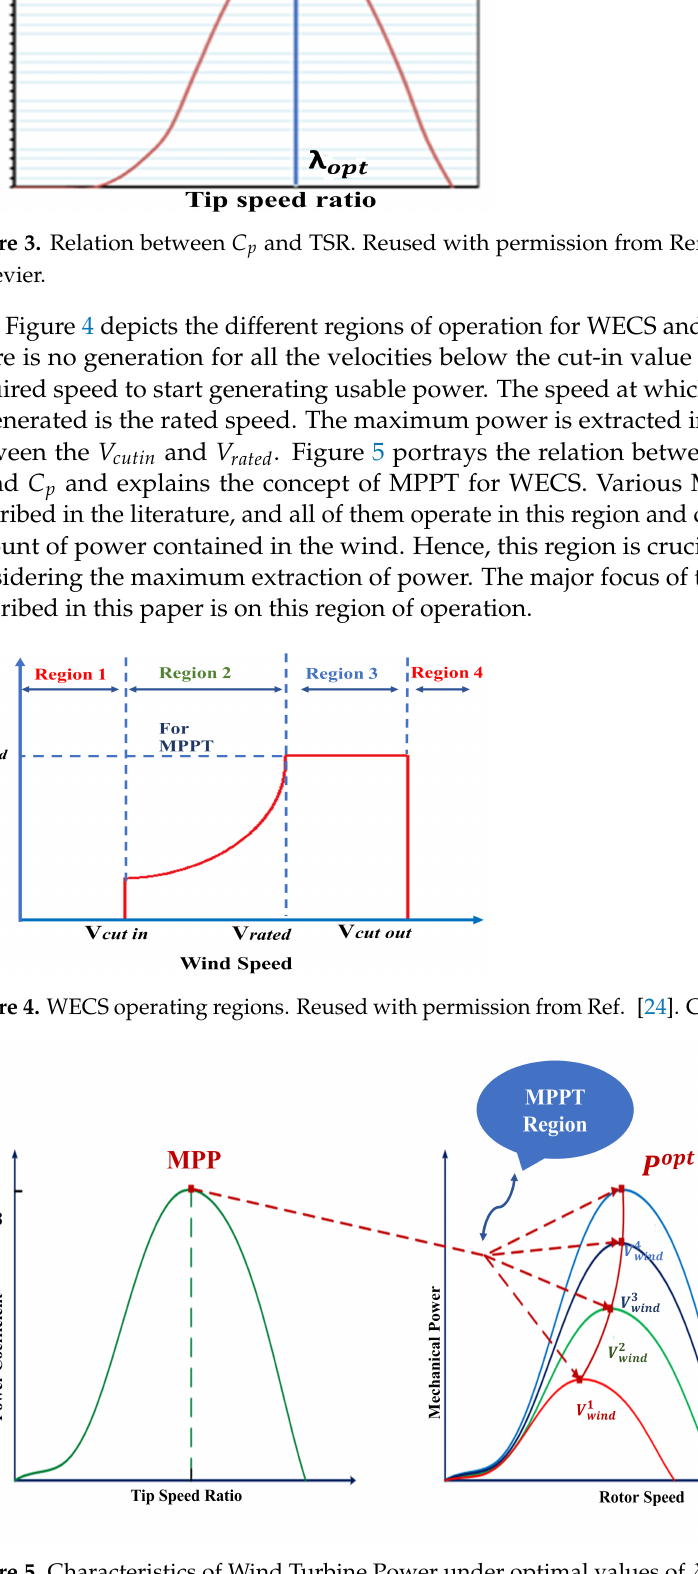
Figure 5. Characteristics of Wind Turbine Power under optimal values of λ opt and C popt . Reused with permission from Ref. [23]. Copyright 2019